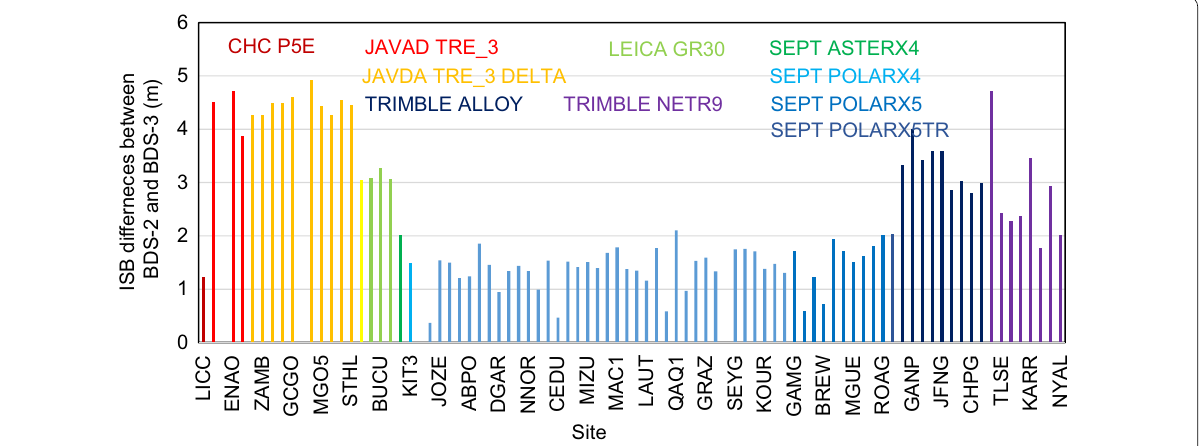
Fig. 6 The inter-system bias for B1I and B3I ionosphere-free combination between BDS-2 and BDS-3 constellation at various stations